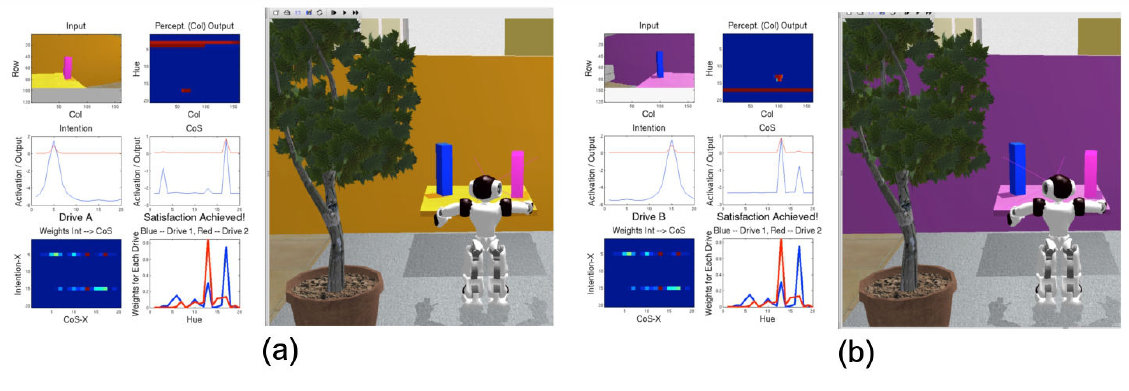
Figure 8: NAO after learning. After learning, the NAO only receives a boost in activation of the CoS field for the correctly rewarding color. When Drive A is active (shown in (a)), the CoS field is selectively excited for the pink object, while for Drive B (shown in (b)), it is selectively activated the blue